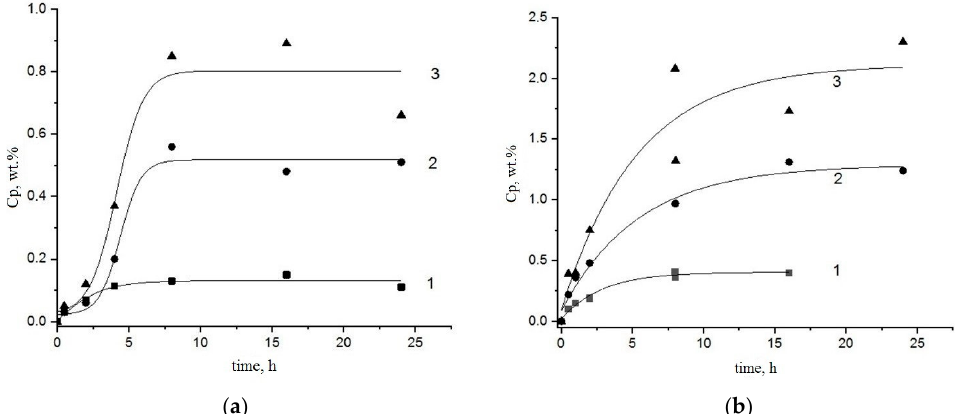
Figure 4. Kinetic curves of Fe 3+ sorption by PLA-chitosan ( a ) and PHB-chitosan ( b ) films (50:50) wt. % from Fe С l 3 aquatic solutions with different concentrations 0.002 (1), 0.005 (2), 0.008 (3) mol/L. The comparison between two families of the kinetic curves for PLA-chitosan and siderably exceeds the same characteristic of the former. In other words, the replacement